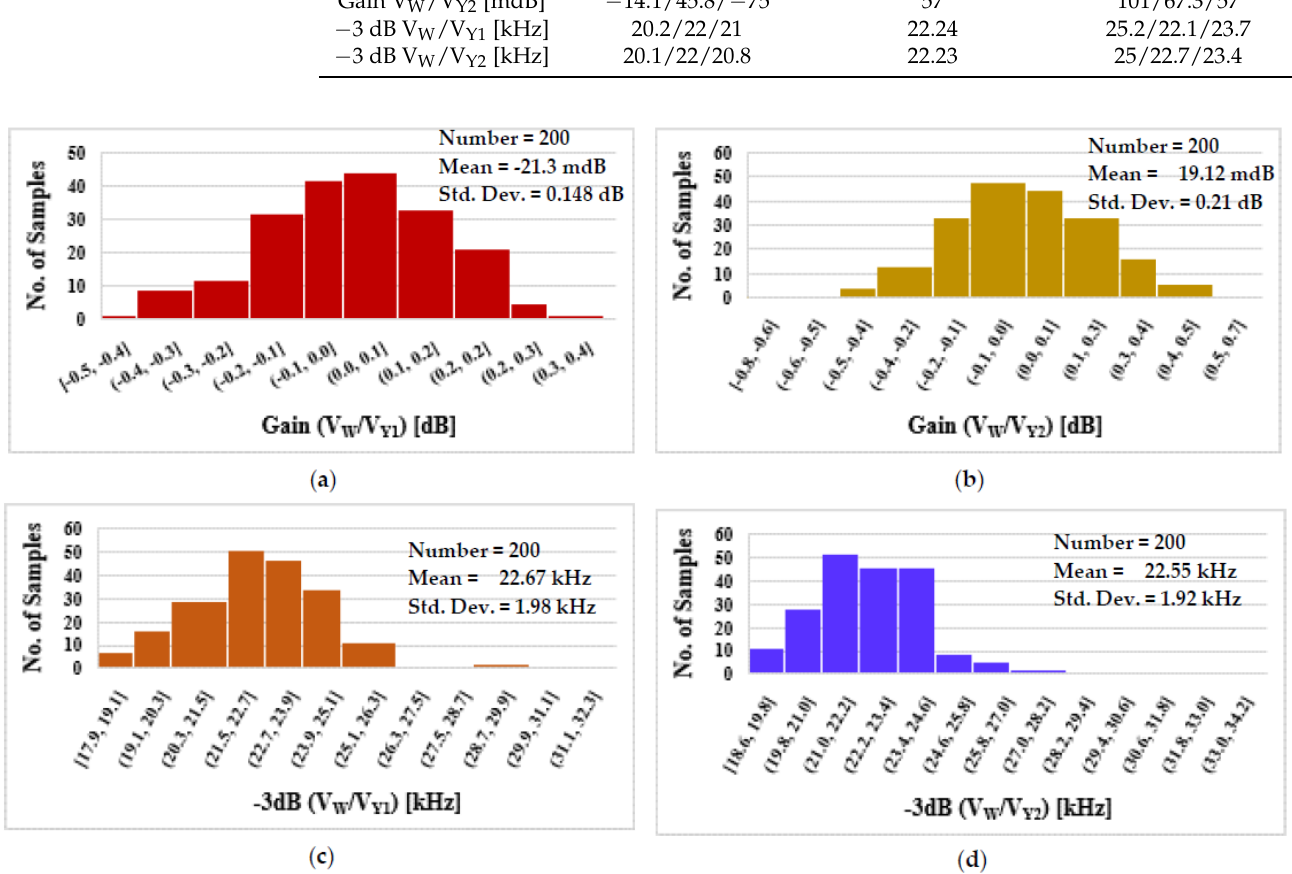
Figure 10. The DDCC histogram of the gain V w /V Y1 ( a ), V w /V Y2 ( b ), and the − 3 dB BW V w /V Y1 ( c ), and V w /V Y2 ( d ).